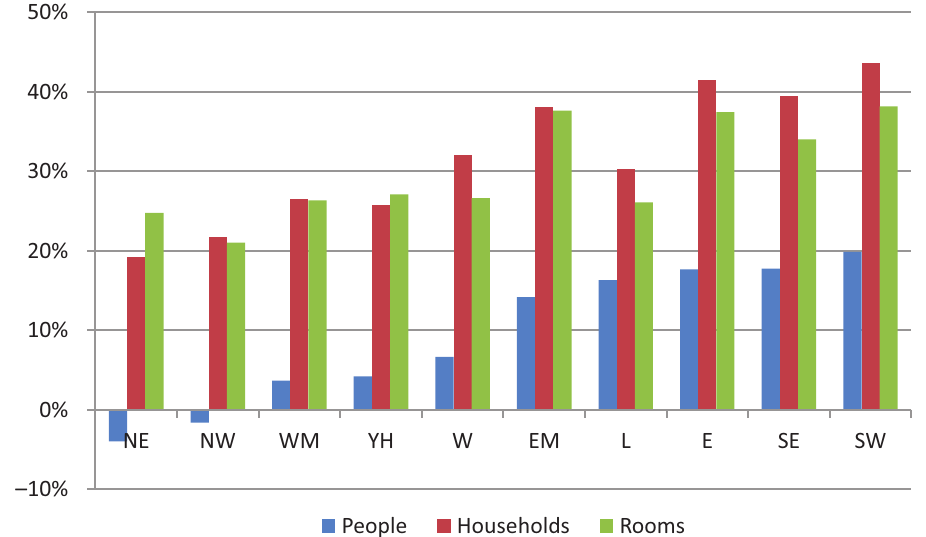
Figure 3. Rates of growth in numbers of people, households and rooms, regions, 1981–2011. Compiled by the author based on data from Casweb for 1981 and Nomisweb for 2011. The initials identify regions: West Midlands (WM); Yorkshire and Humberside (YH); Wales (W); East Midlands (EM); London (L). The remainder of initials refer to regions named after points of the